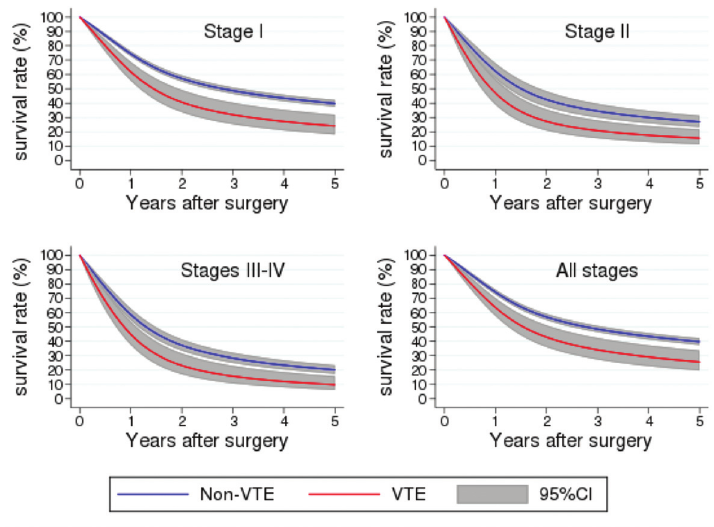
Fig. 2 Adjusted survival for patients with and without a postoperative VTE ( p < 0.002). VTE, venous thromboembolism.